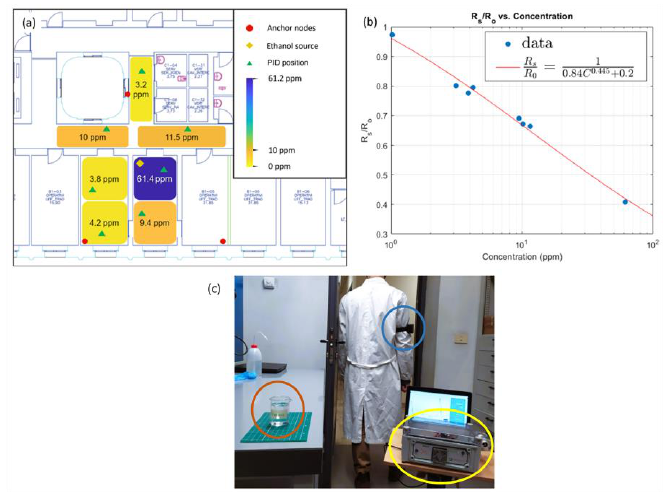
Figure 12. Ethanol source placement in the test site. Red dots show the location of the anchor nodes, green triangles are the PID fixed positions, and the yellow diamond is the ethanol source. We reported the concentration measured with PID in each zone ( a ). Relationship between the BME680 MOx resistance and the ethanol concentration measured with PID ( b ) Experimental setup: red circle shows the ethanol source, the yellow circle shows the PID, and the blue circle shows the sensing node worn by the operator ( c ).